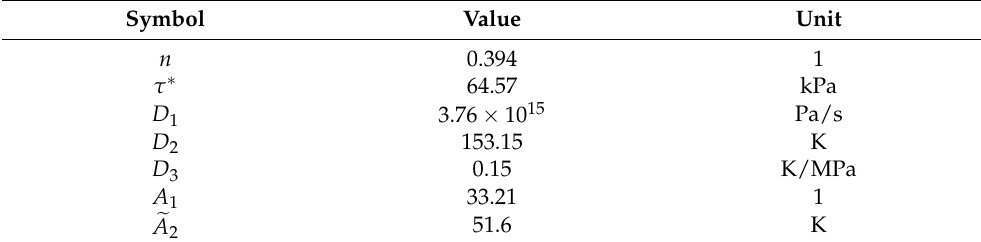
Table 3. Cross-WLF viscosity model parameters (modified from [35]).